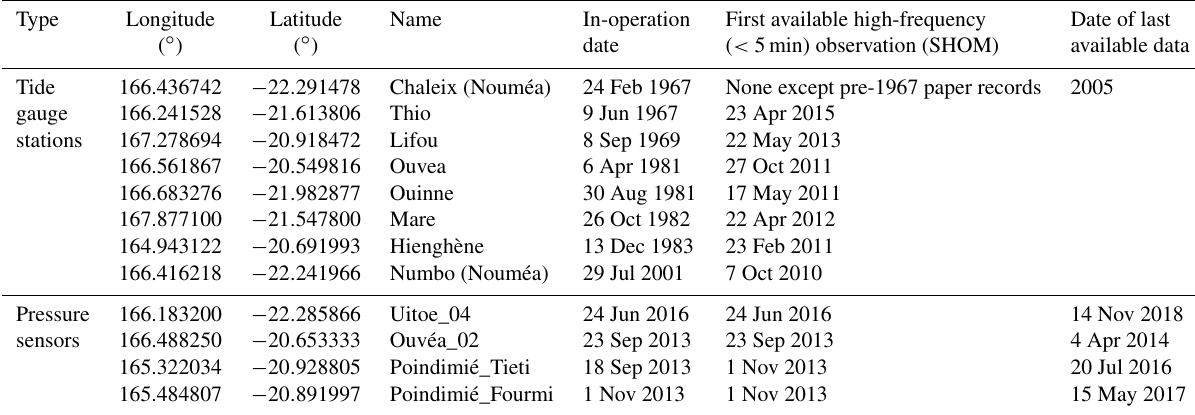
Table 1. Permanent tide gauge locations and pressure sensors in New Caledonia.